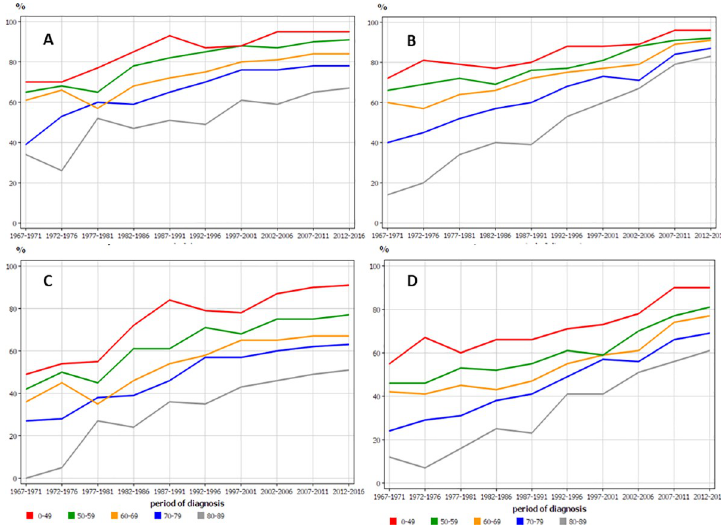
Fig 4. Age-specific 1-year relative survival for RCC in Finnish (A) and Swedish (B) women, and the related 5-year survival in the same female populations (C,